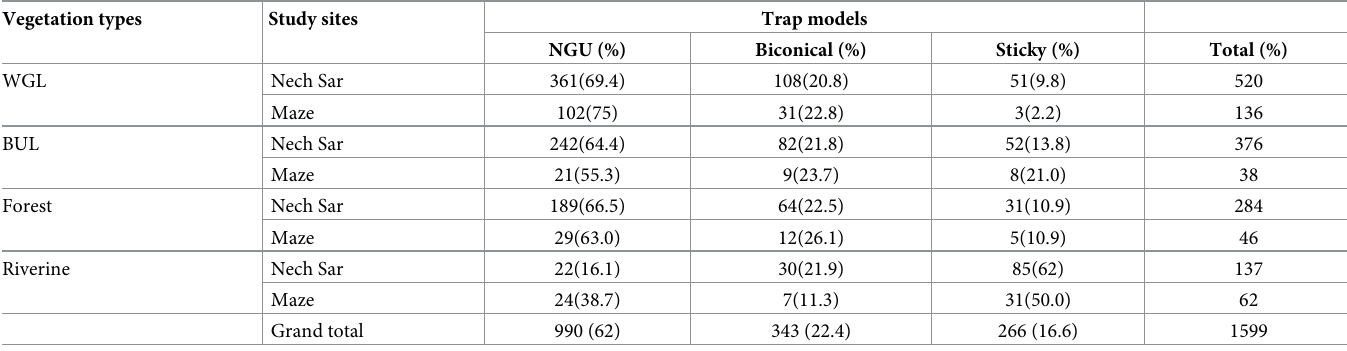
Table 3. Overall number of flies collected from different vegetation types using the three trap types in Nech Sar and Maze National Parks, Southwest Ethiopia. Vegetation